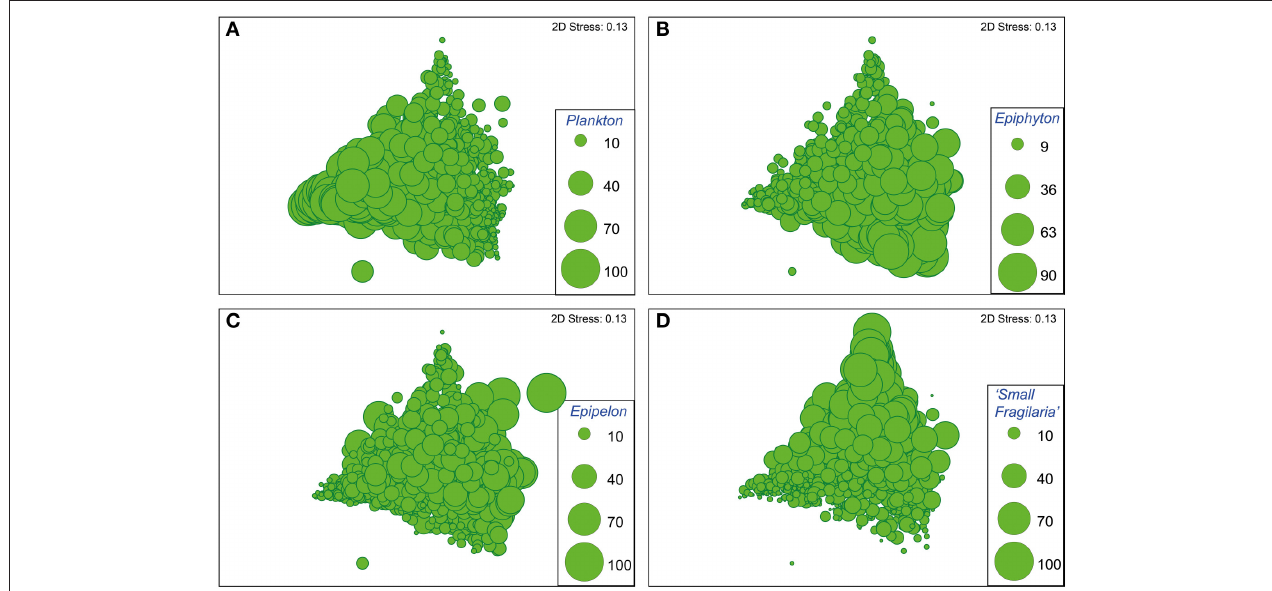
FIGURE 4 | Bubble plots of the full 17-billabong data set (966 samples) on nMDS axes 1 and 2 based on a resemblance matrix of Bray-Curtis similarity measures using relative abundances of diatoms grouped according to preferred habitat (planktonic, epiphytic, epipelic, small Fragilaria ). Bubble size indicates the relative abundance of planktonic (A) , epiphytic (B) , epipelic (C) , and small Fragilaria (D) diatoms. 2D stress values indicate the degree that the 2-dimensional ordination represents a distortion of the relationships between samples in the resemblance matrix, with 0 representing perfect representation. Values greater than 0.3 indicate points are close to being arbitrarily placed in the 2-dimensional ordination, thus the 2D stress value of 0.14 indicates the ordination is suitable for illustrating general patterns ( Clarke and Warwick,